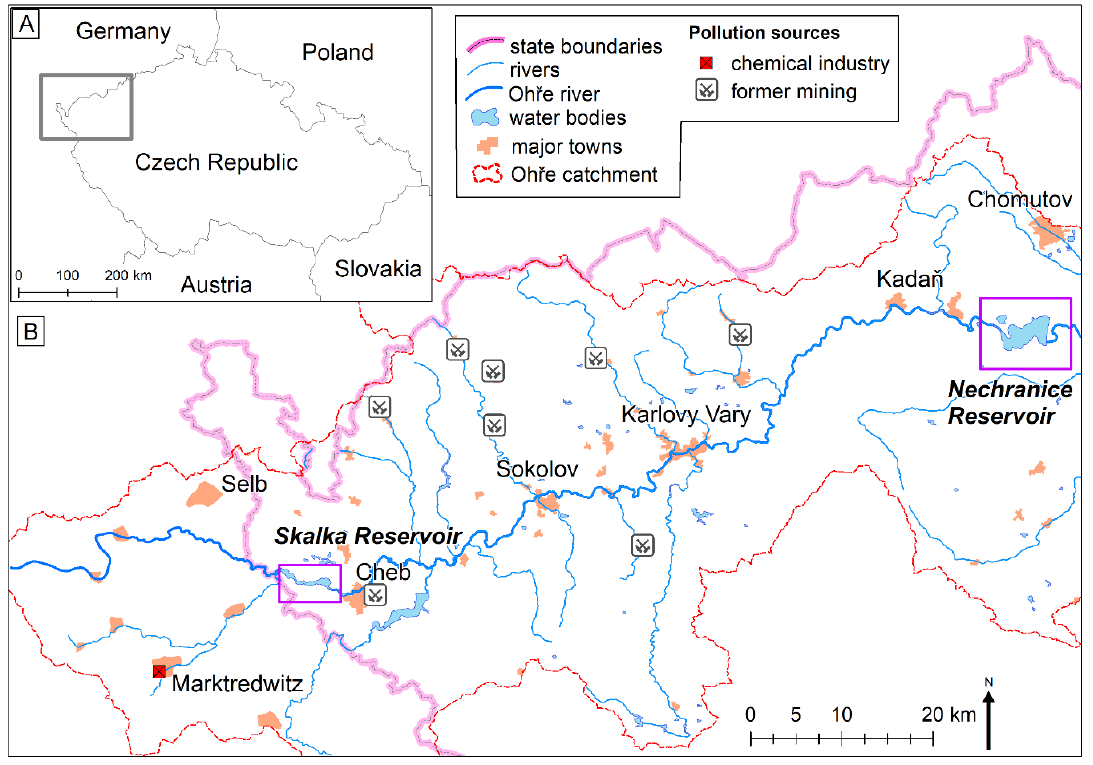
Figure 1. Map of the upper and middle reaches of the Ohˇre River with the positions of major historical sources of pollution by risk elements and the two studied